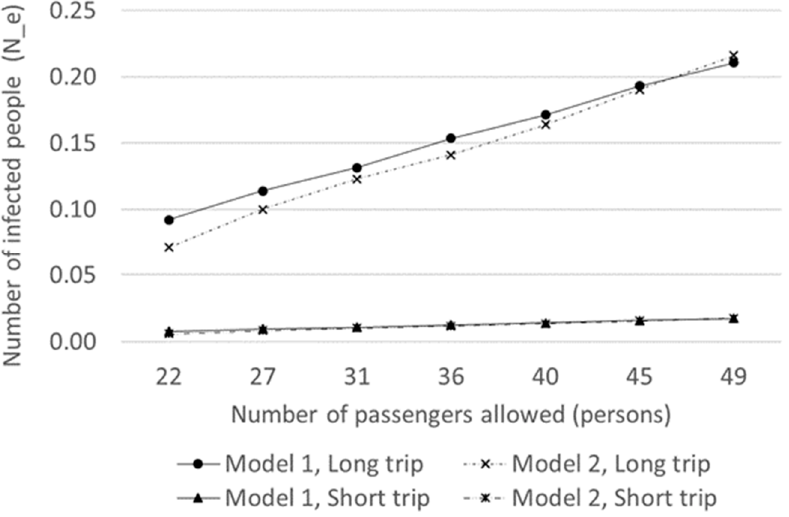
Figure 7. Changes in the risk of infection due to the reduction in the number of passengers under short- and long-distance travel conditions.